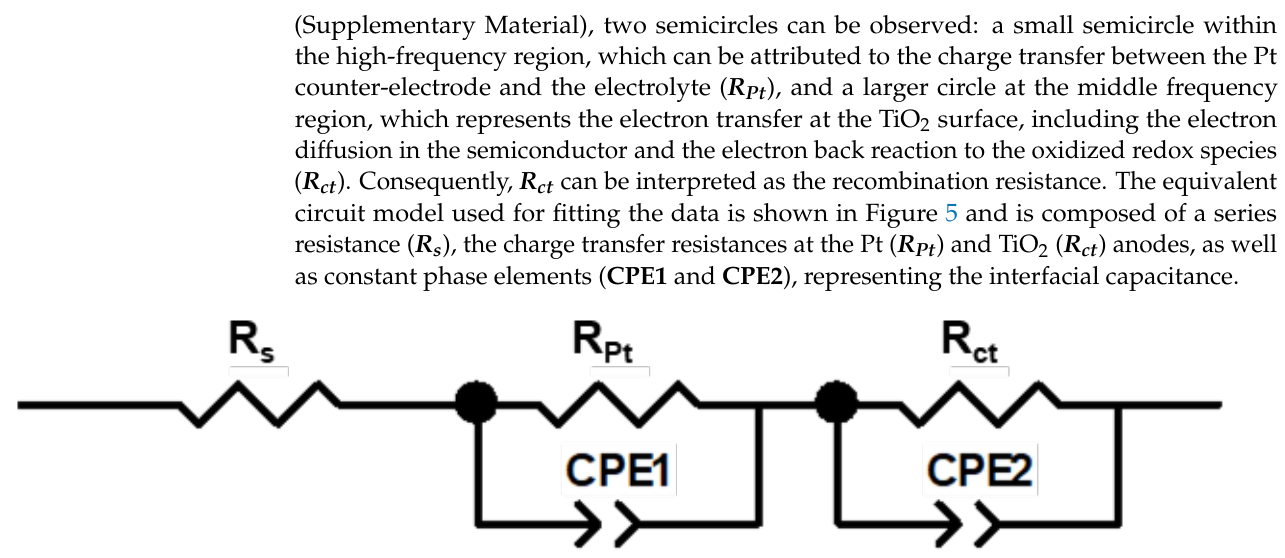
Figure 5. Representation of the equivalent circuit used to fit the EIS data. Figure 5 . Representation of the equivalent circuit used to fit the EIS data.